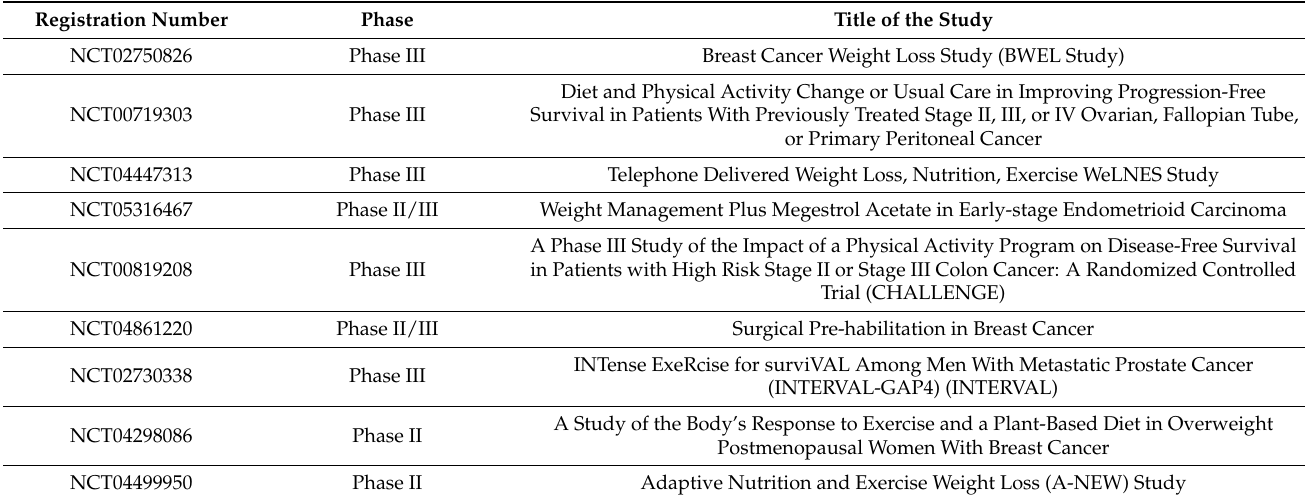
Table 5. Current studies in cancer and